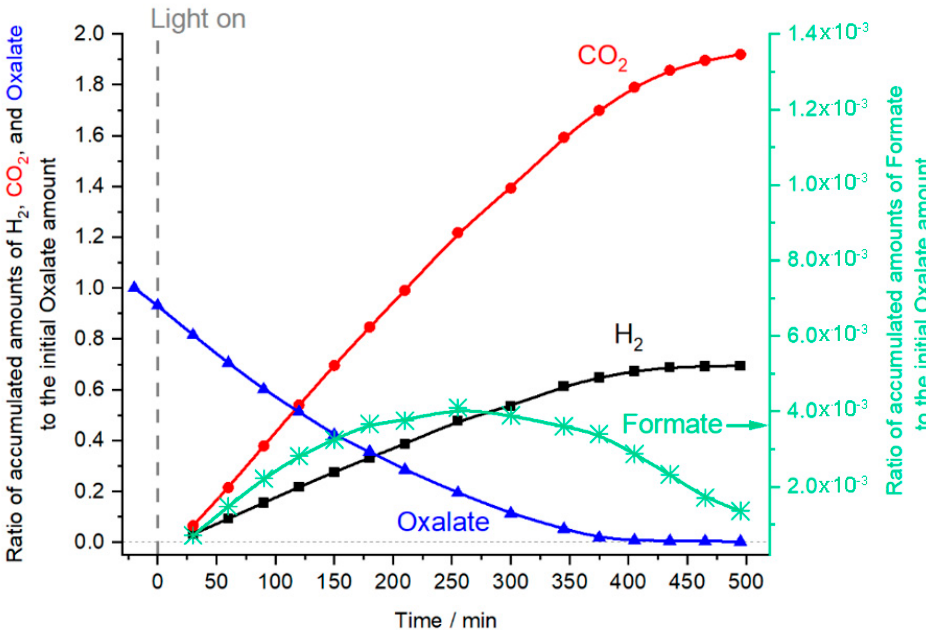
Figure 1. Relative amounts of evolved H 2 , CO 2 , and formate, besides decomposed oxalate, to the initial amount of oxalic acid. A 50 mL aqueous suspension containing 1.11 mmol L − 1 oxalic acid and Pt/TiO 2 at pH ~3. A longpass filter with a cut-on wavelength of 310 nm was used.